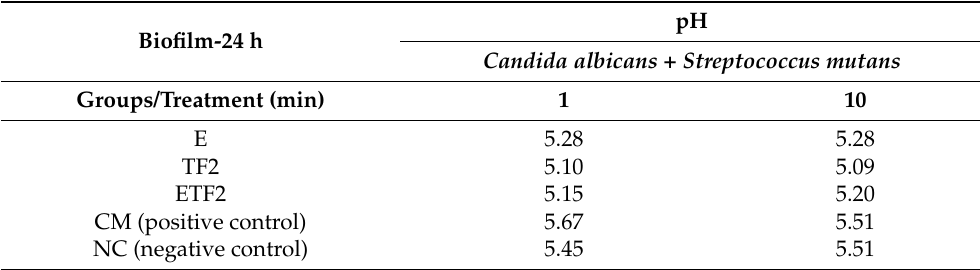
Table 4. pH values of Candida albicans and Streptococcus mutans dual-biofilms formed for 24 h and treated for 1 or 10 min.